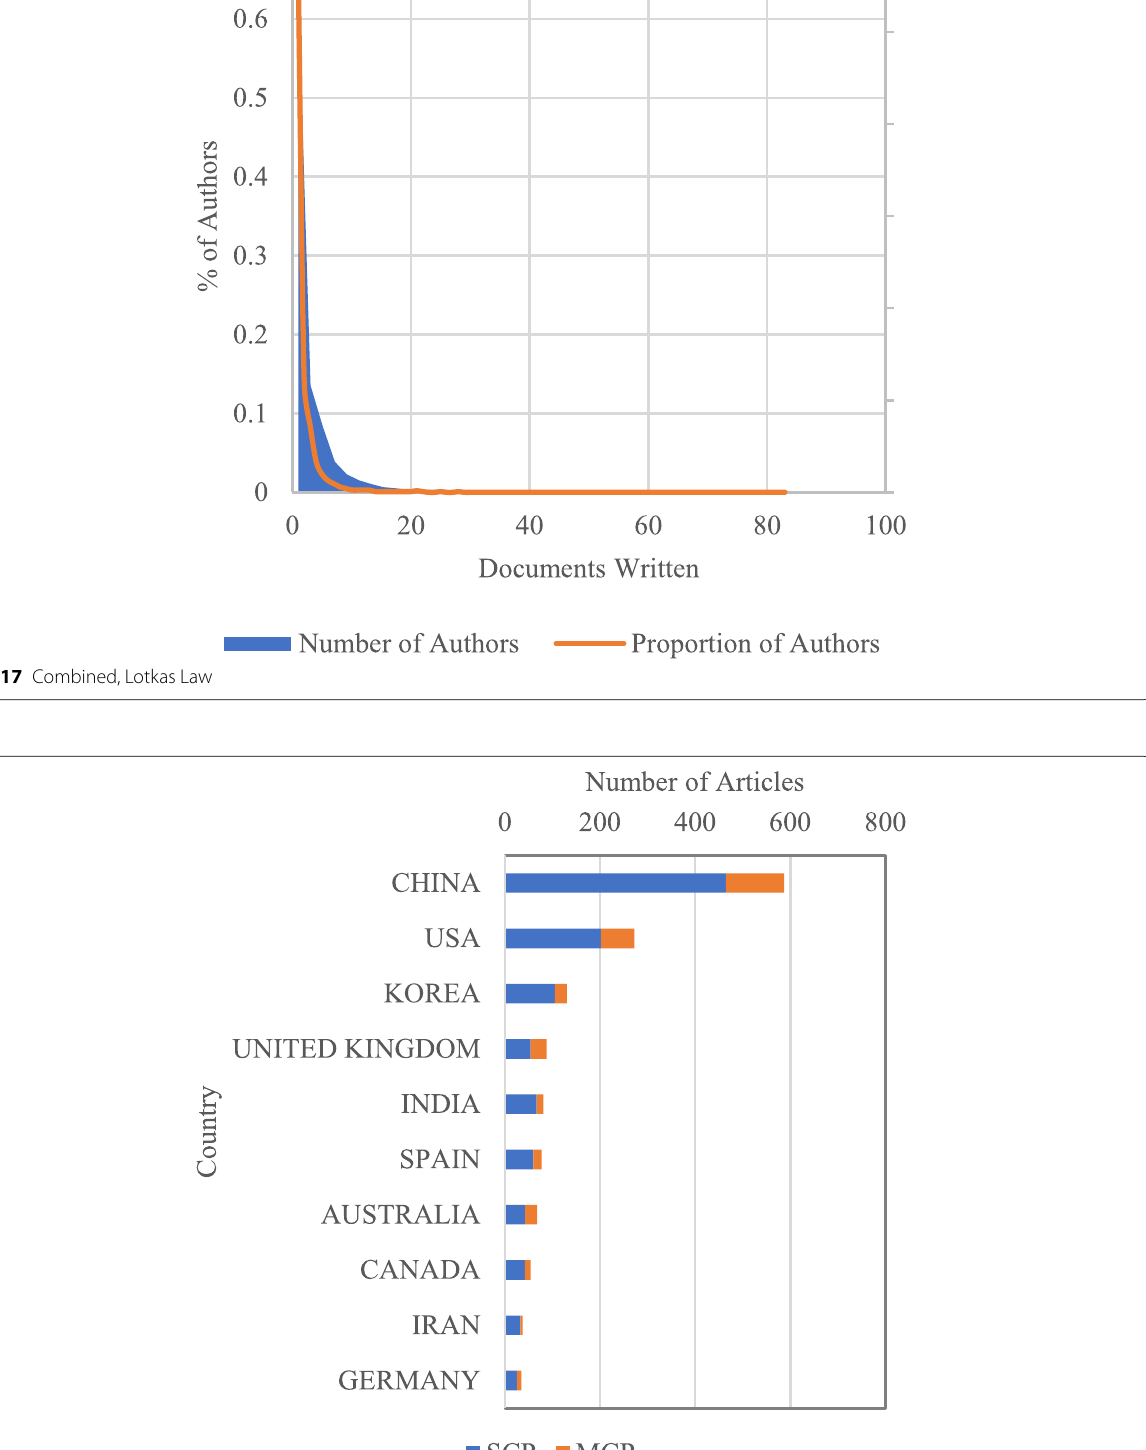
Fig. 18 Adsorbents, top contributing